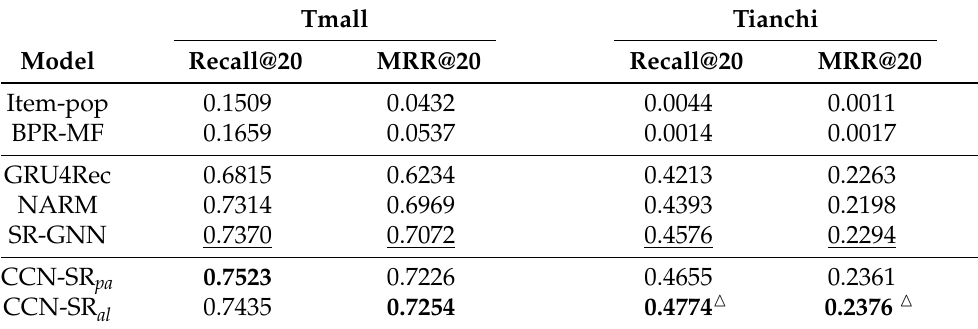
Table 3. Performance of recommendation models. The results produced by the best baseline and the best performer in each column are underlined and boldfaced, respectively. Statistical significance of pairwise differences of best model vs. the best baseline is determined by a paired t -test ( p -value ≤